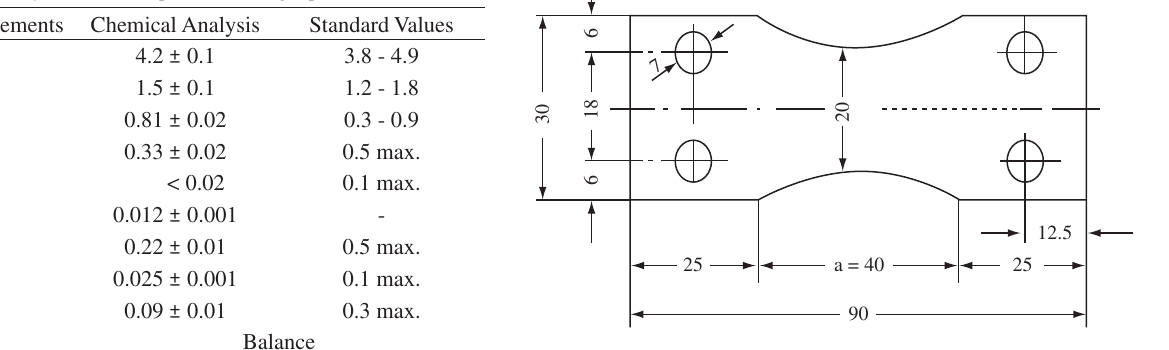
Figure 1. Fatigue sample dimensions in millimeters. Thickness: 3.5 mm.